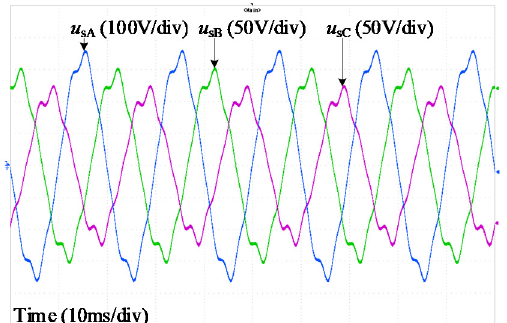
Figure 8. Waveforms of the three ‐ phase unbalanced and distorted source voltages.